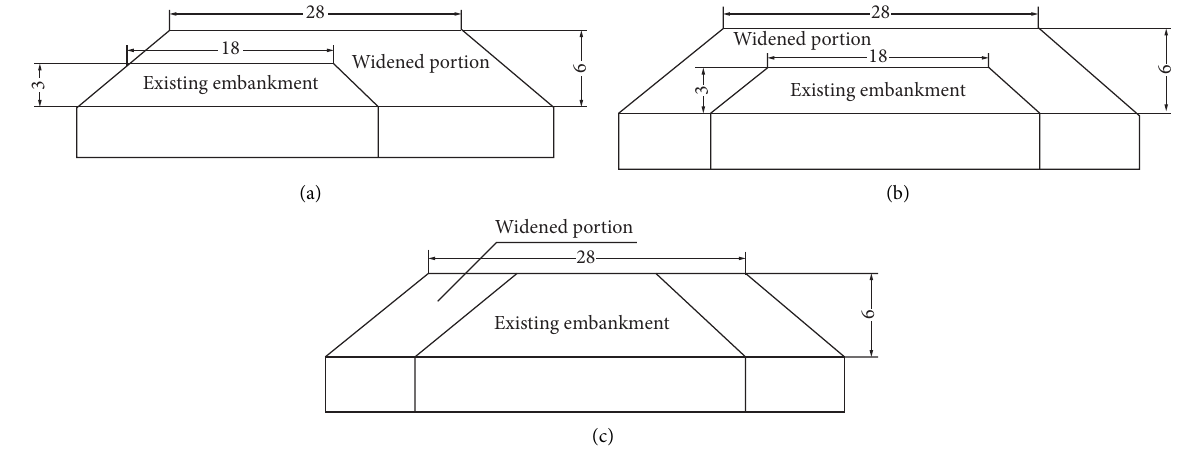
Figure 2: Schematic diagram of three calculation conditions (unit: m).